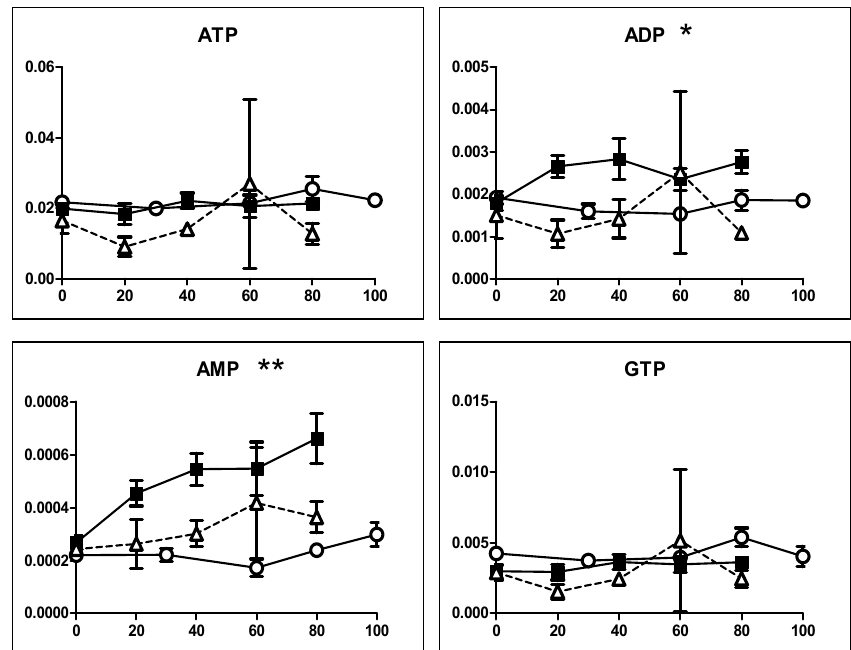
Figure 11. Eugenol generally does not affect the ATP concentrations. HPC ( 〇 ), HPLF ( ■ ), HGF ( △ ). Vertical axis, μ mol/cell. Three groups were compared by one-way ANOVA (no post test). * p < 0.05, ** p < 0.01.